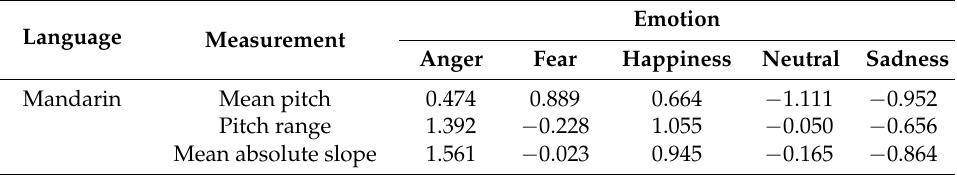
Table 2. Normalized mean values of five emotions in each